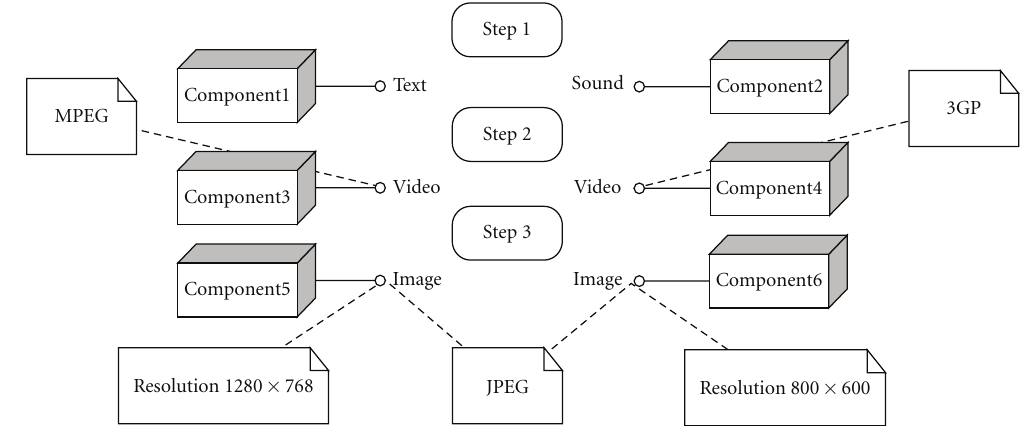
Figure 9: Heterogeneity between components.